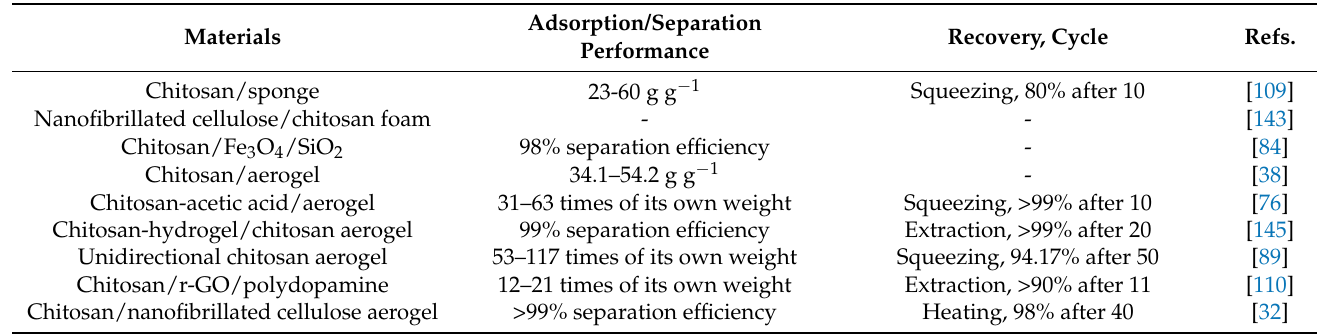
Figure 11. Mechanism of water selectively collected in CSHA: ( a ) The CSHA with the core/shell- like structure. ( b ) The hydrogel shell of the CSHA forbids further absorption of oil molecules, while water molecules are still able to penetrate the aerogel core until all pores are saturated. ( c ) Many water molecules absorbed on the surface of the CSHA and hydrogen bonds formed in and between molecules (red and blue dashed lines). At the same time, the CS aerogel is translated into the hydrogel. ( d ) Schematic of the aerogel core, that hydrogen bonds (red dashed lines) as the primary intermolecular interactions. Reproduced with permission [145]. Copyright 2020, American Chemical Society. Table 5. Chitosan based sorbents for spill oil